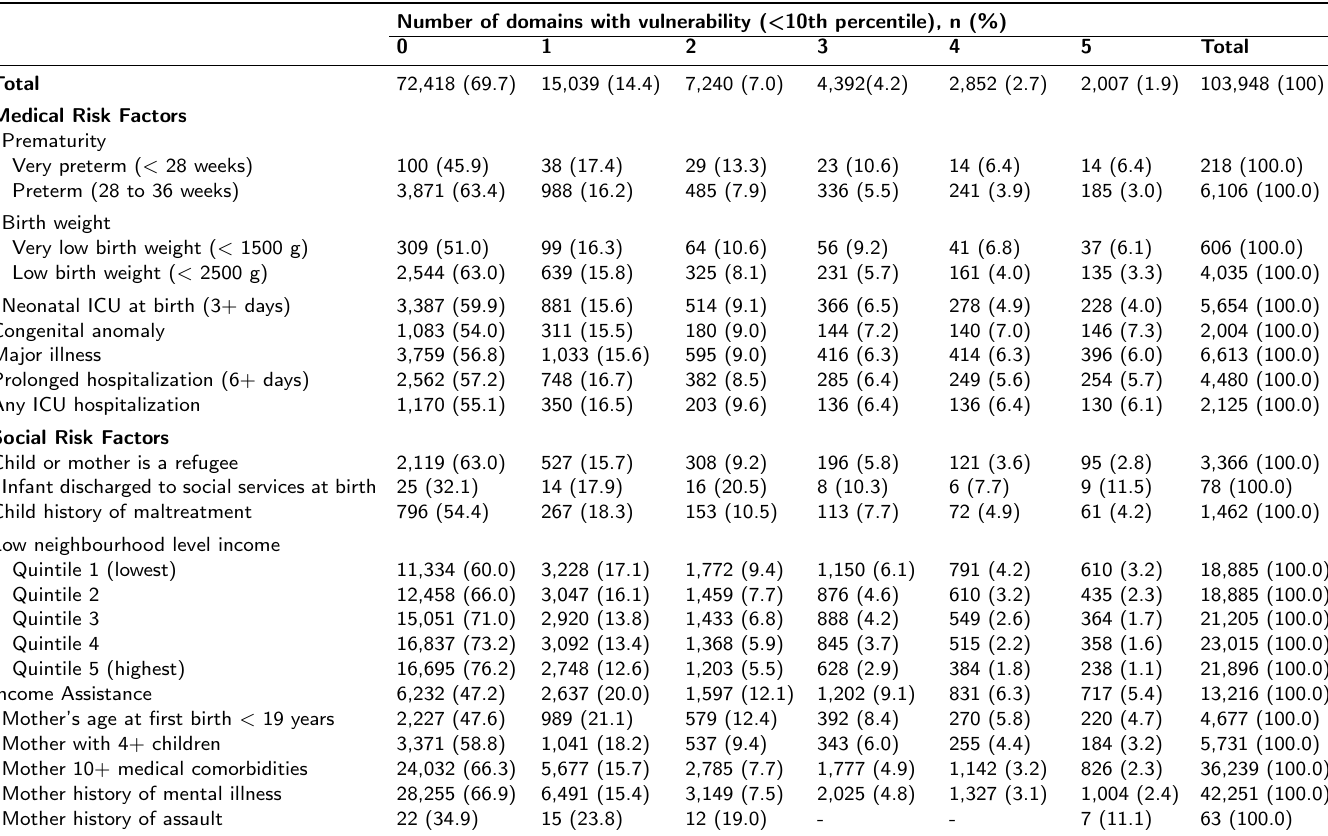
Table 4: Number of domains with reported vulnerability for the 2015 early development instrument cohort overall and by medical and social risk